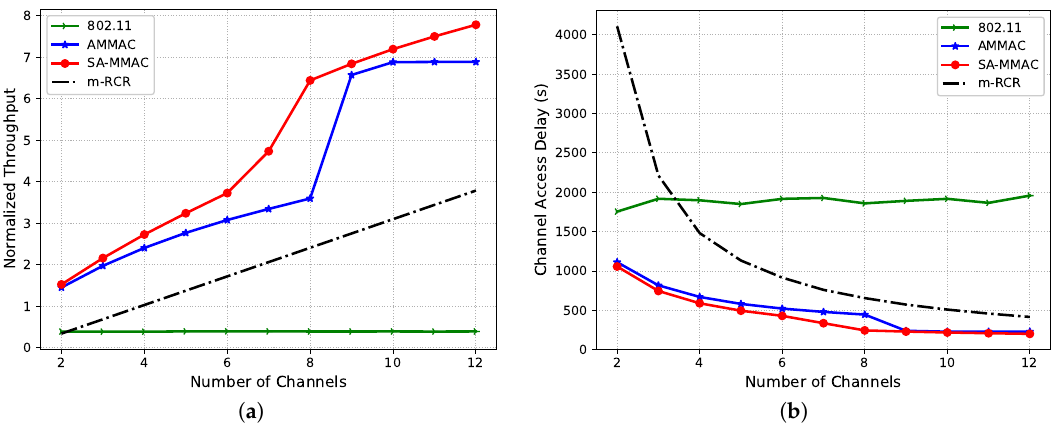
Figure 8. Performance of protocols for a densely populated network of 200 nodes. ( a ) Saturation Throughput; ( b ) Access